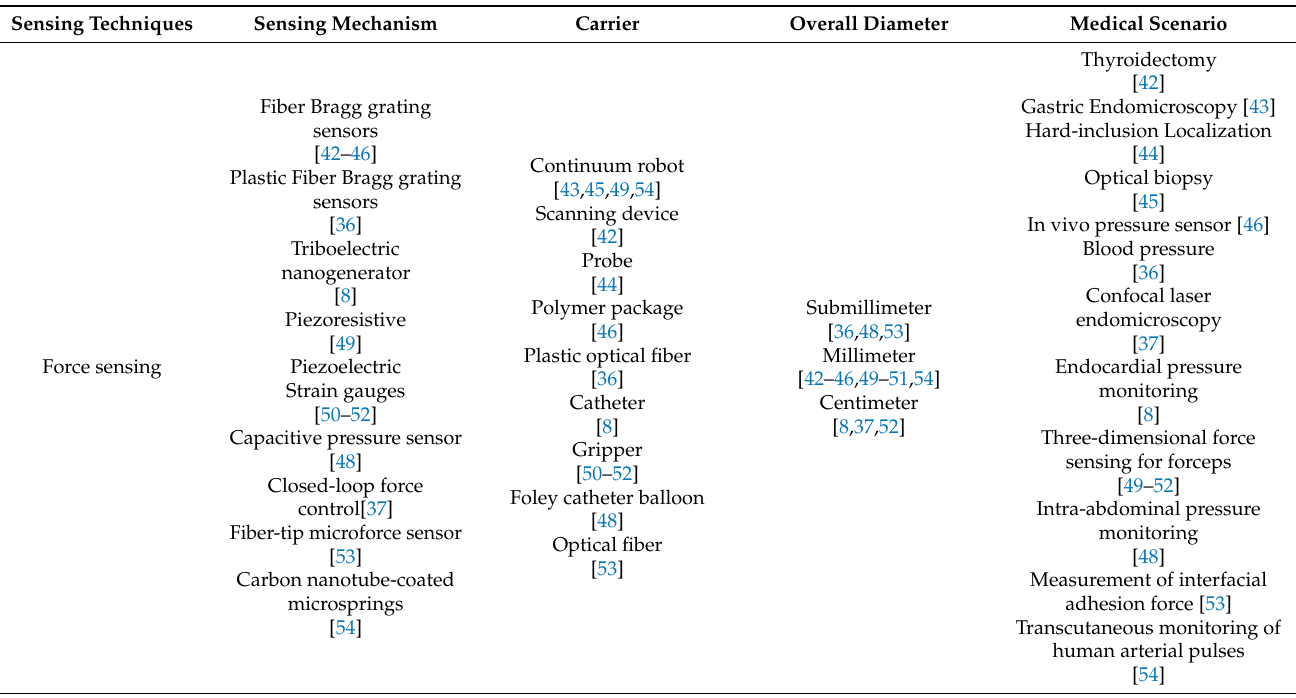
Table 2. Comparison between probe-based sensing